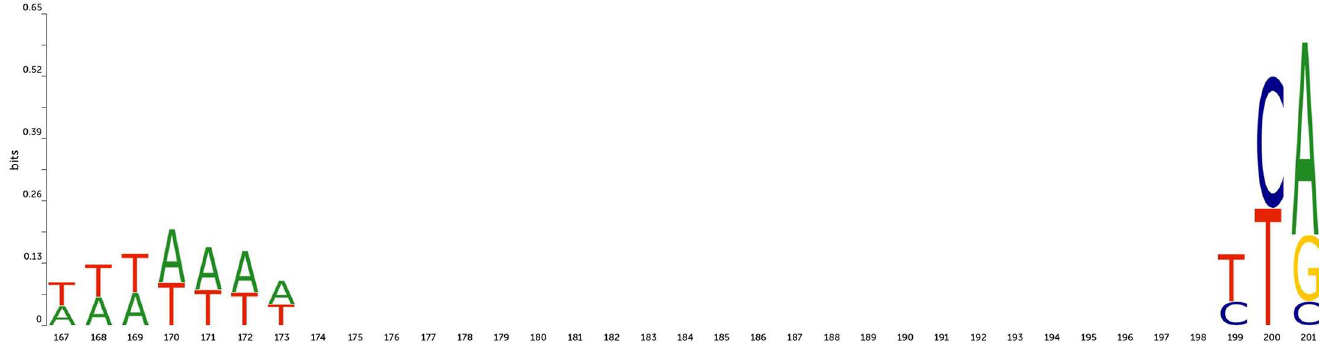
Fig 6. Sequence logo for Arabidopsis non-TATA promoter sequences. X-axis is a position in promotersequence,Y-axis is informational content in bits.